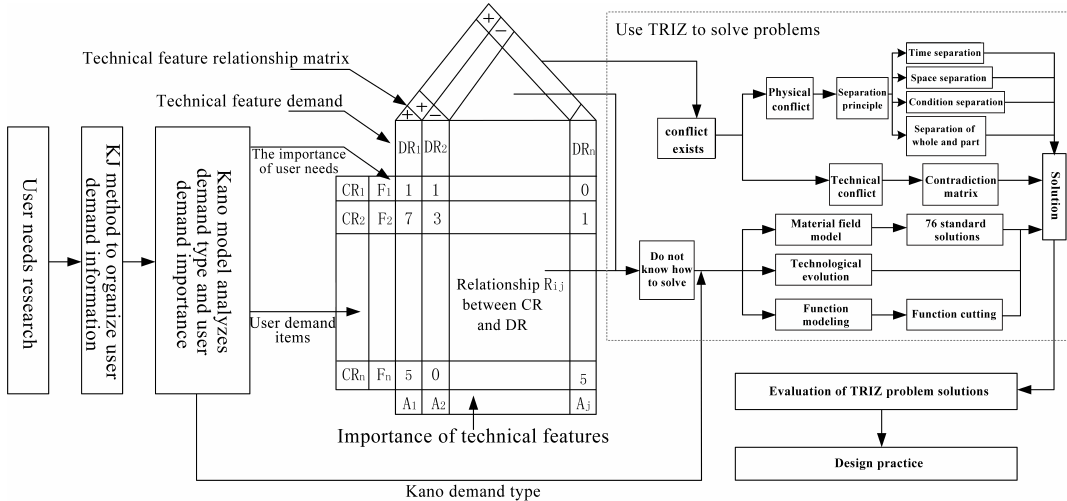
Figure 1. Product innovation based on the Kano-QFD-TRIZ